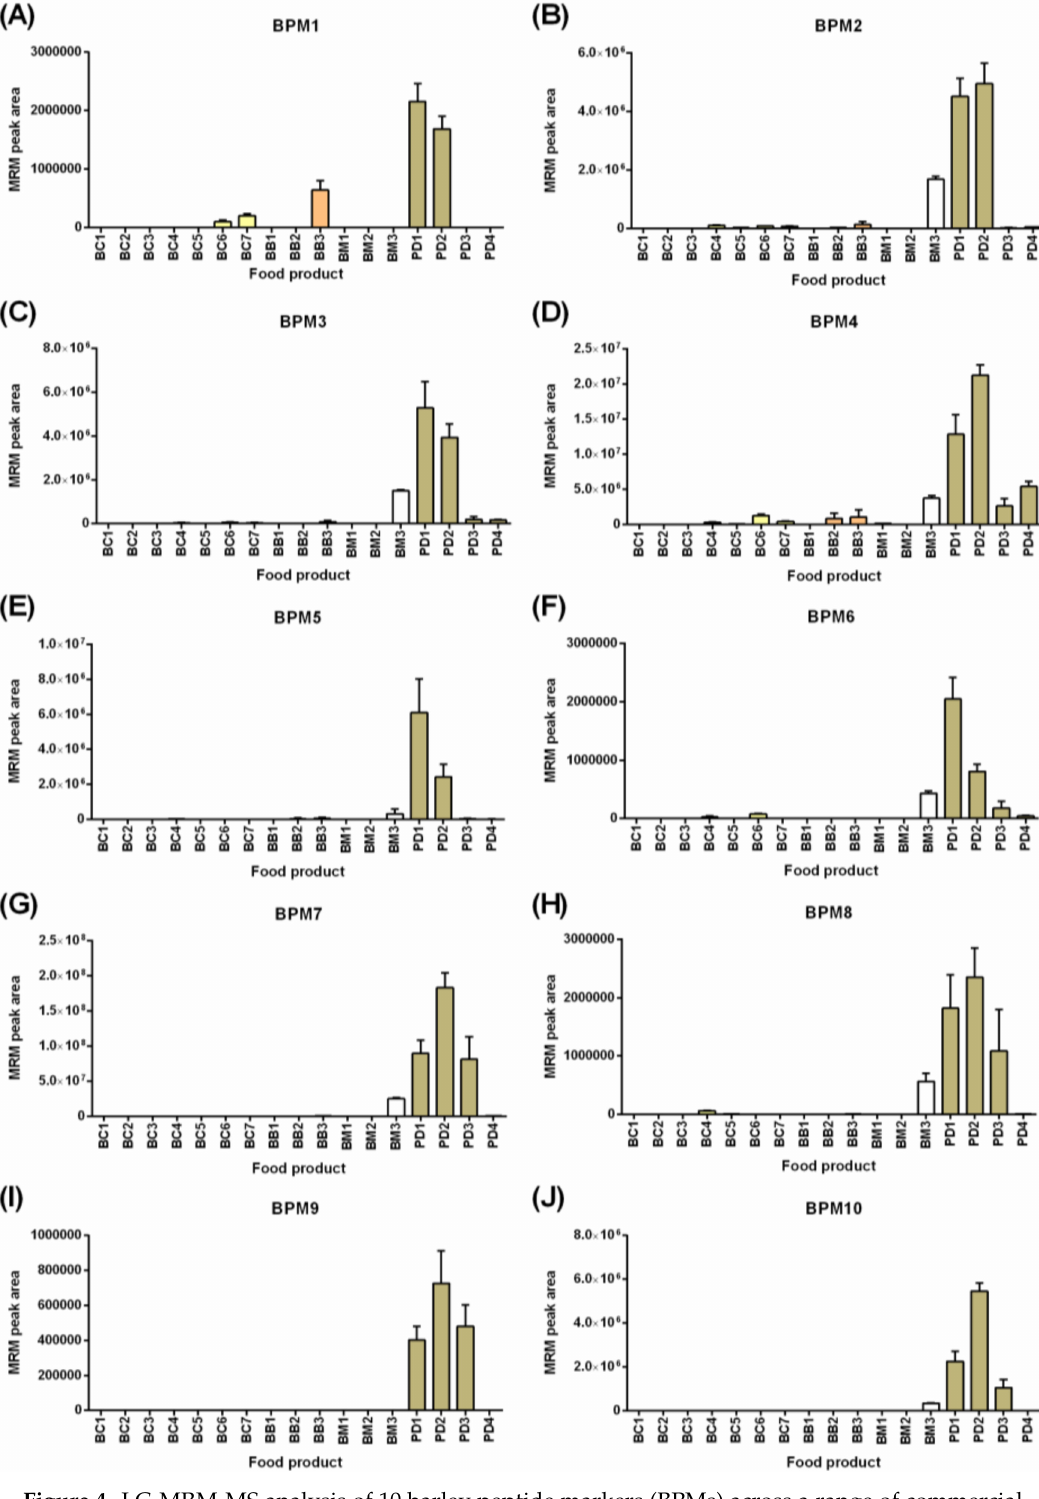
Figure 4. LC-MRM-MS analysis of 10 barley peptide markers (BPMs) across a range of commercial Australian breakfast food products. The peak area + SD is plotted ( n = 4). Panels ( A ) through ( J ) refer to the ten BPMs defined in Table